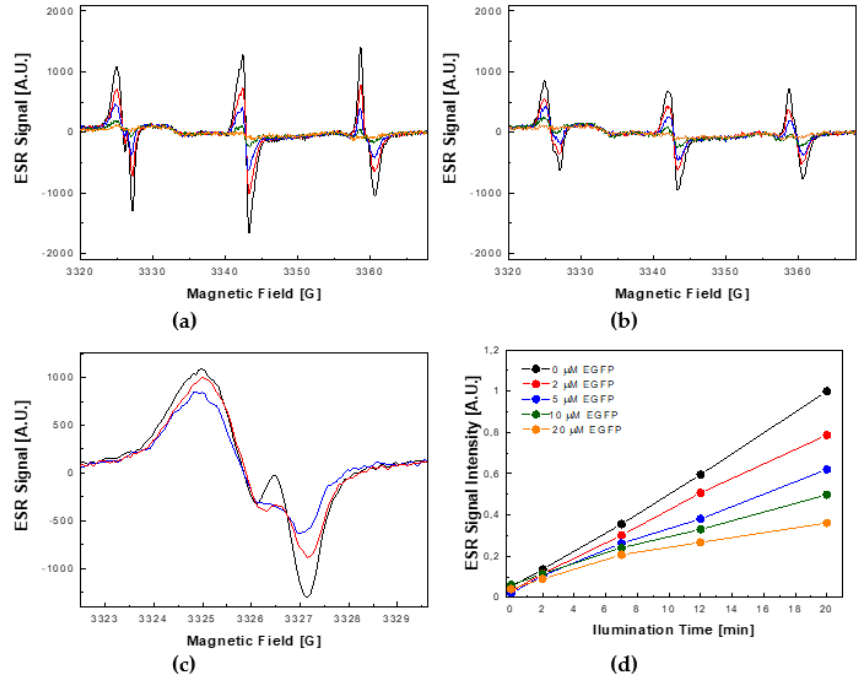
Figure 4 . Photosensitized generation of a singlet oxygen ( 1 Δ g ) and superoxide radicals (O 2•− ) by 50 μM rose bengal under visible light illumination in the absence and presence of EGFP. ( a ) Growth of the complex ESR signal containing the components of TEMPOL and TEMPONE, as a function of the illumination time in the absence of EGFP. ( b ) Growth of the complex ESR signal containing the components of TEMPOL and TEMPONE as a function of the illumination time in the presence of 5 μM EGFP. The ESR spectra presented in panels ( a , b ) were recorded in the dark (orange) and after 2 (green), 7 (blue), 12 (red), and 20 (black) min of visible light illumination. ( c ) Overlaid low-field features of the complex ESR signal acquired after 20 min of visible light illumination for the photosensitization processes performed in the absence of EGFP (black trace) and in the presence of 2 μM EGFP (red trace) and 5 μM EGFP (blue trace). ( d ) Time-evolutions of the signal amplitude of the low-field feature of the ESR spectra of TEMPOL observed in the absence of EGFP (black dots) and in the presence of 2 μM EGFP (red dots), 5 μM EGFP (blue dots), 10 μM EGFP (green dots), and 20 μM EGFP (orange dots).